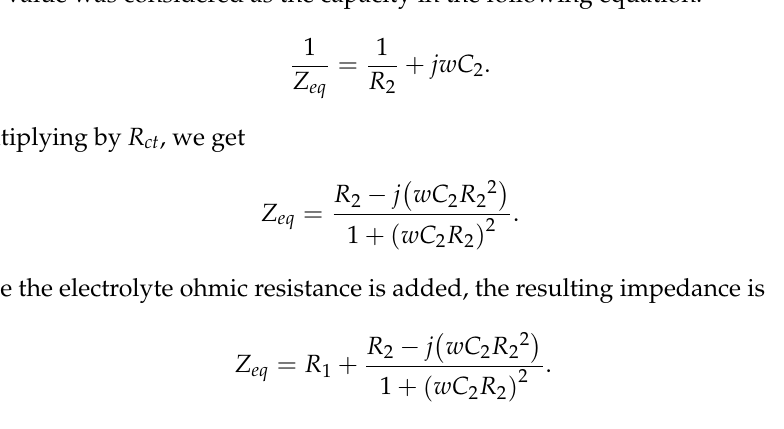
Figure 8. Equivalent circuit to fit the impedance data.